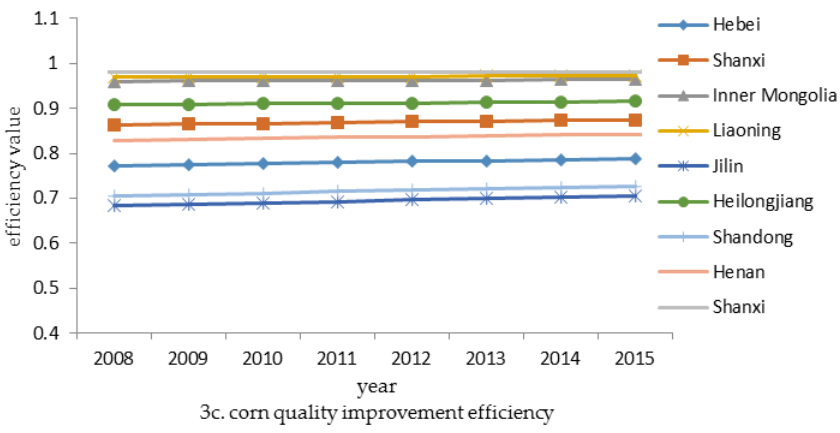
Figure 3. Trends of grain quality improvement efficiency in all samples.